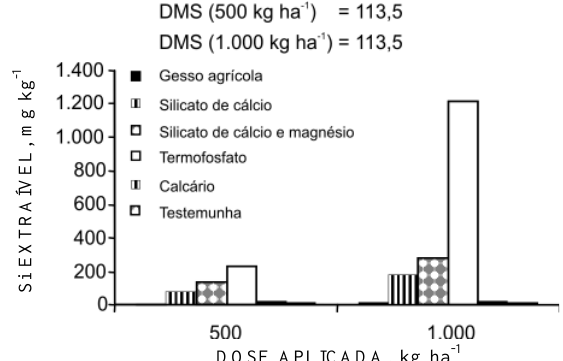
Figura 2. Concentração de silício (extrator ácido acético 0,5 mol L -1 ) nos lisímetros (camada de 0–5 cm) preenchidos com terra de um Neossolo Quartzarênico órtico típico.